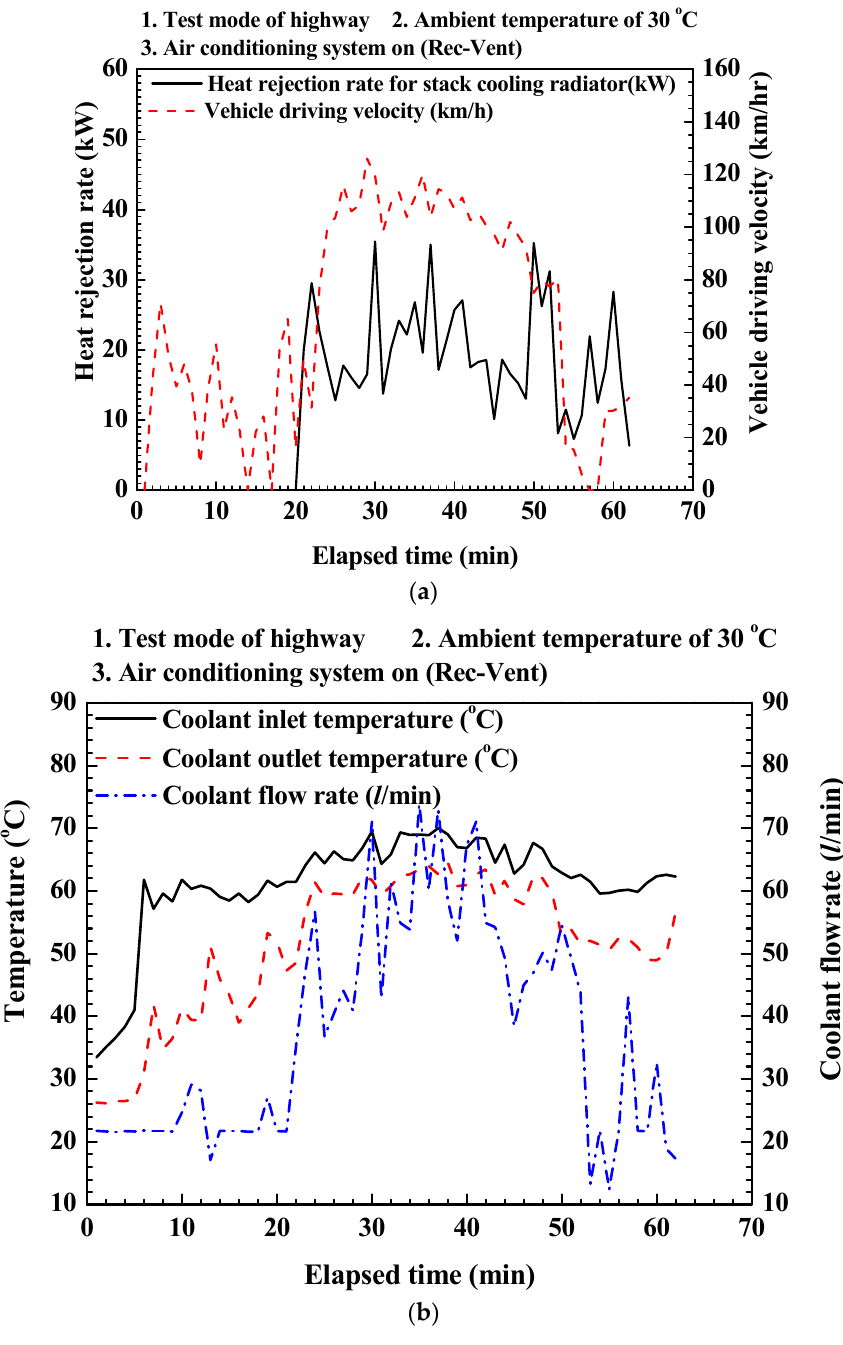
Figure 3. Cooling performance of the stack thermal management system of the fuel ‐ cell electric vehicle, under highway ‐ driving road conditions. ( a ) Heat ‐ rejection rate; ( b ) Temperature and coolant flow rate.